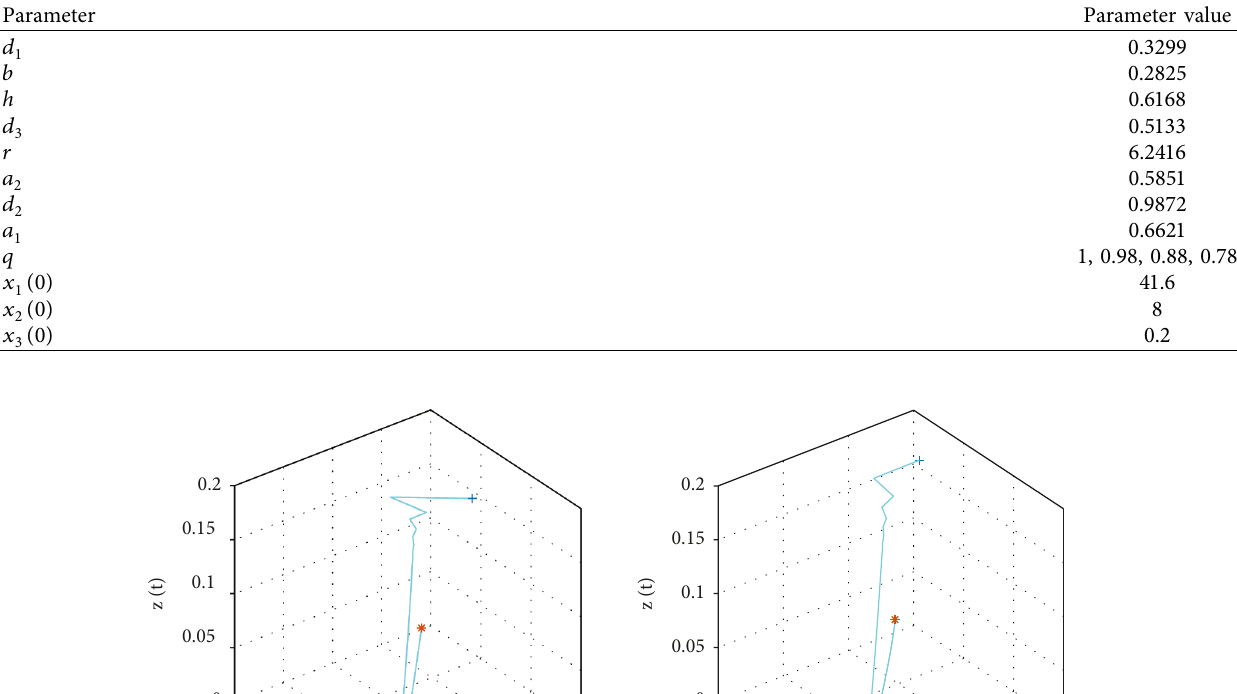
Table 2: Parameter values of the equilibrium point e